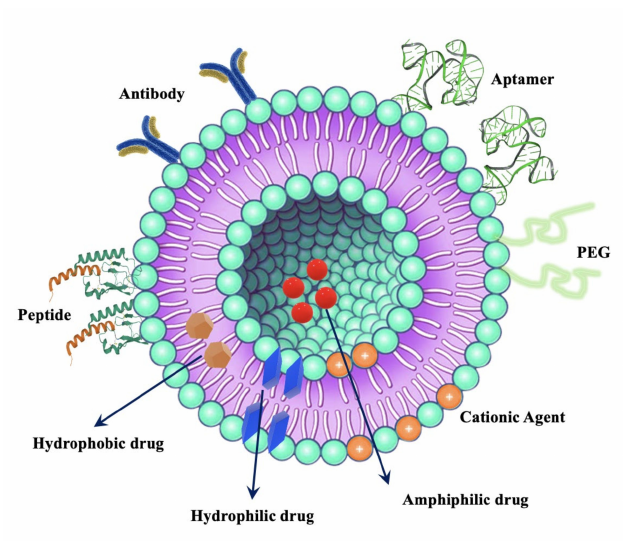
Figure 2. Schematic representation of the main liposomal drugs and targeting agents that improve liposome a ffi nity and selectivity for brain delivery. PEG: polyethylene glycol. Lakkadwala et al. [87] formulated and characterized a dual-functionalized liposome-based nanotherapeutic system by surface modification with transferrin (Tf) and peptide-penetratin (Pen) for receptor-mediated transcytosis and increased penetration to cell, respectively (Figure 3).